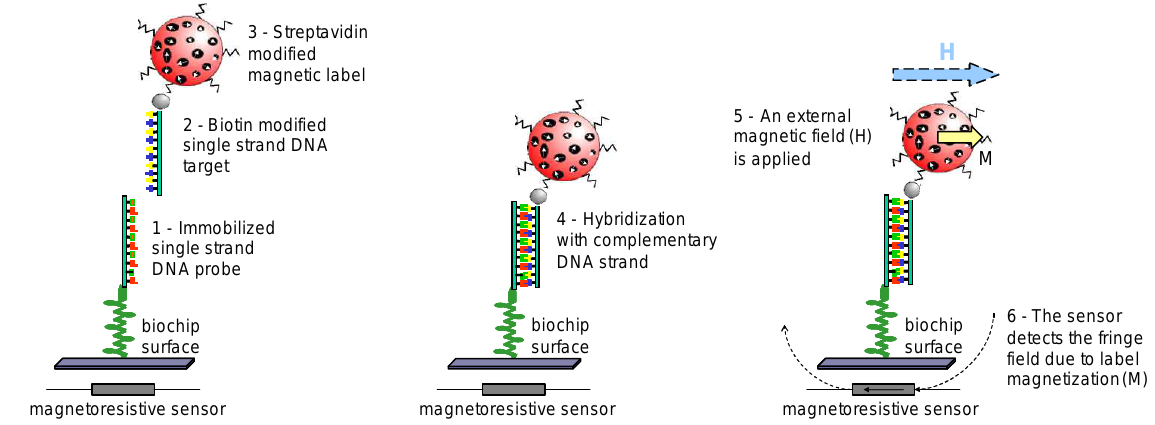
Figure 1. Detection of complementary single strand